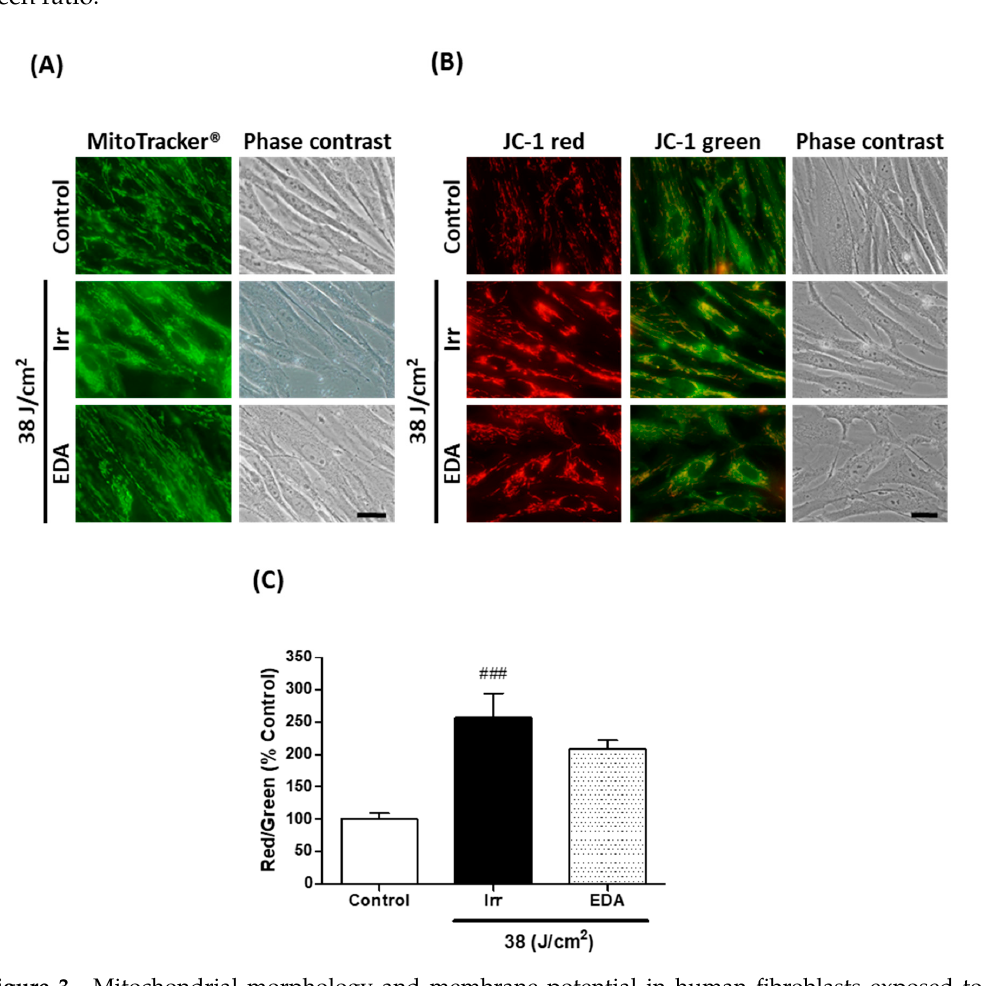
Figure 3. Mitochondrial morphology and membrane potential in human fibroblasts exposed to artificial blue light and EDA pre-treatment. Cells were incubated with EDA 0.1 mg / mL for 24 h, irradiated at 38 J / cm 2 and incubated with MitoTracker ® or loaded with JC-1 to be observed under the microscope 24 h after irradiation. Mitochondrial morphology was documented using the fluorescent probe MitoTracker ® ( A ). Mitochondrial membrane potential was evaluated with the dye JC-1 ( B ). Quantification of JC-1 red / green fluorescence ratio ( n ≥ 5) ( C ). Data are shown as mean ± SEM. ### p < 0.001 vs control. Scale bar: 20 µm.